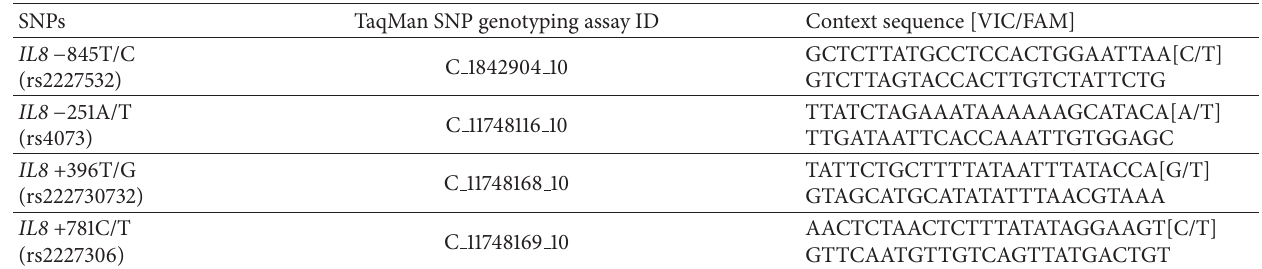
Table 1: Details of SNPs in IL8 detection.